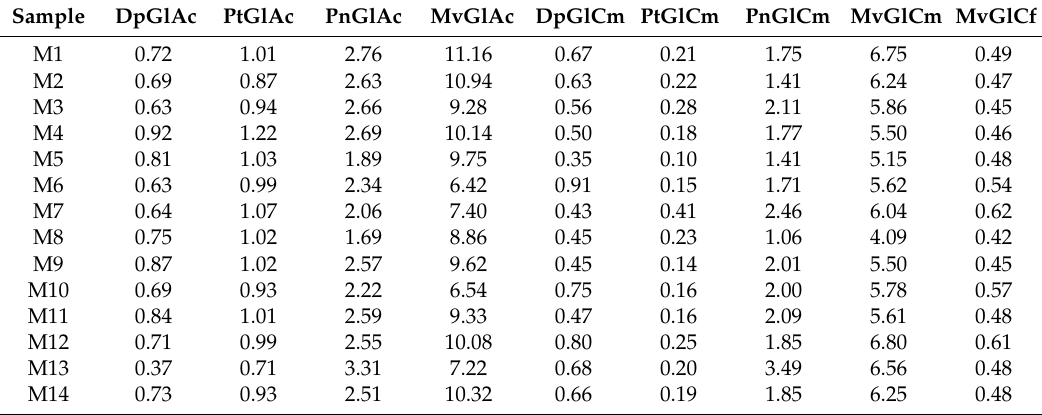
Table 6. Relative content (%) of acylated anthocyanidins in Mencia (M) and Alicante Bouschet young red wines. For key to substances, see